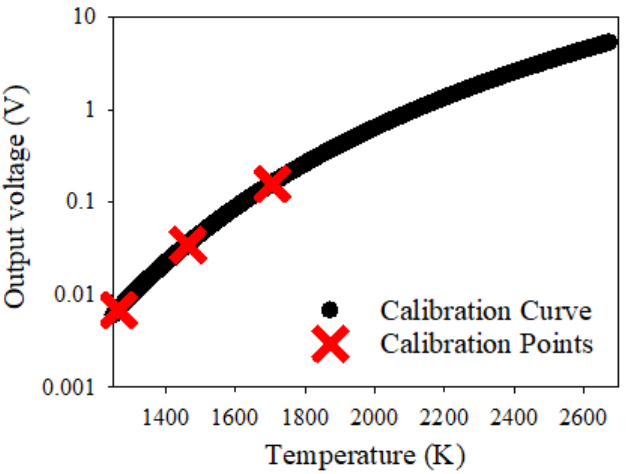
Figure 5. Output voltage as a function of temperature for calibrated IRT. Red crosses represent the calibration points at temperatures of 1265, 1463 and 1705 K.